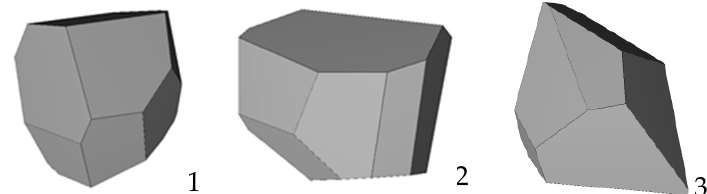
Figure 1. Shapes of the model polyhedron particles.